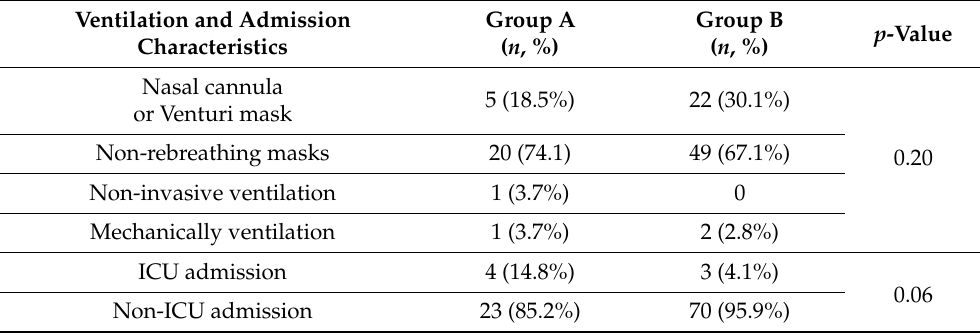
Table 4. Ventilation and admission characteristics in SARS-CoV-2 patients with and without pericar- dial